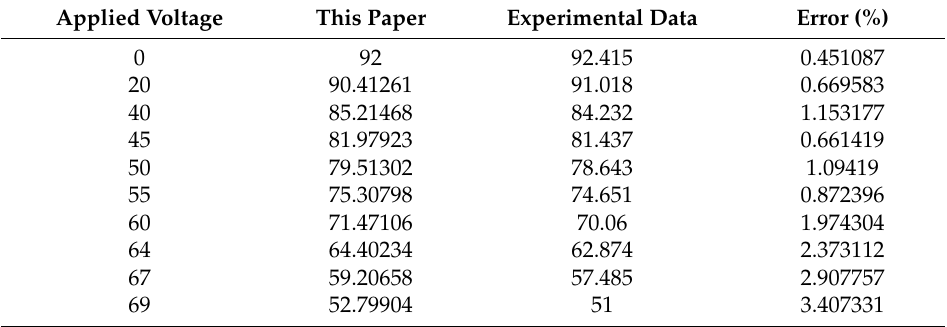
Table 4. Comparison of the results of numerical simulations in this paper with the experimental results [51].